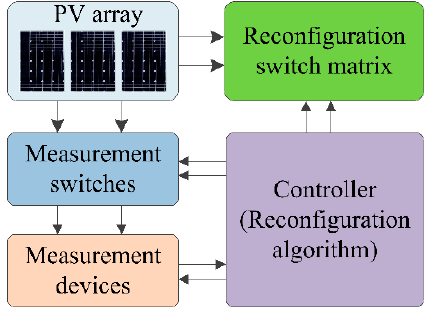
Figure 7. Diagram of the reconfiguration system.